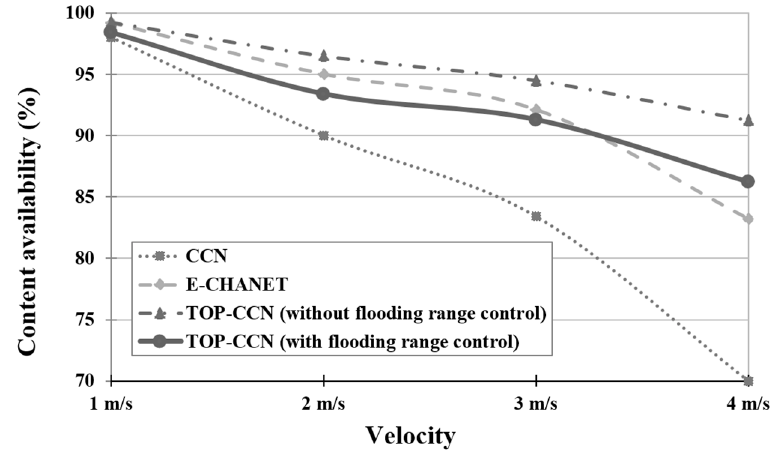
Figure 13. Content availability comparison depending on different connectivity instability levels.